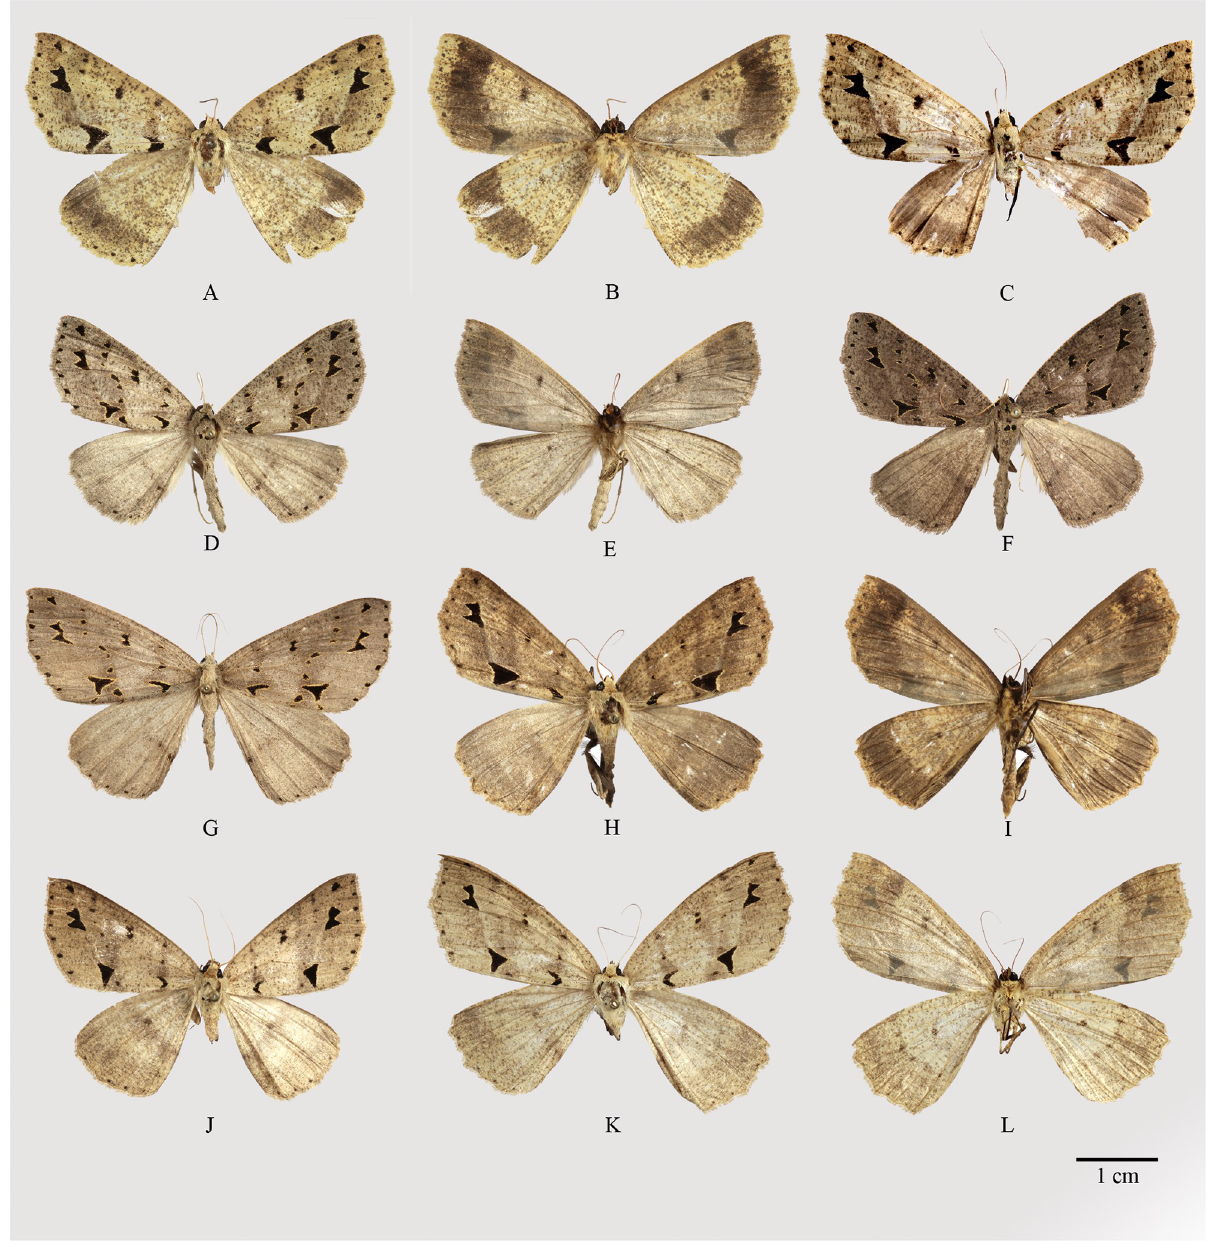
Fig 3. Habitus of Psyra gracilis , P . angulifera , P . cuneata . A. P . gracilis ♂ B. P . gracilis ♂ underside C. P . gracilis ♀ D. P . angulifera ♂ E. P . angulifera ♂ underside F. P . angulifera ♂ (Dark morph) G. P . angulifera ♀ H. P . cuneata ♂ I. P . cuneata ♂ underside J. P . cuneata ♂ (Pale morph) K. P . cuneata ♀ L. P . cuneata ♀